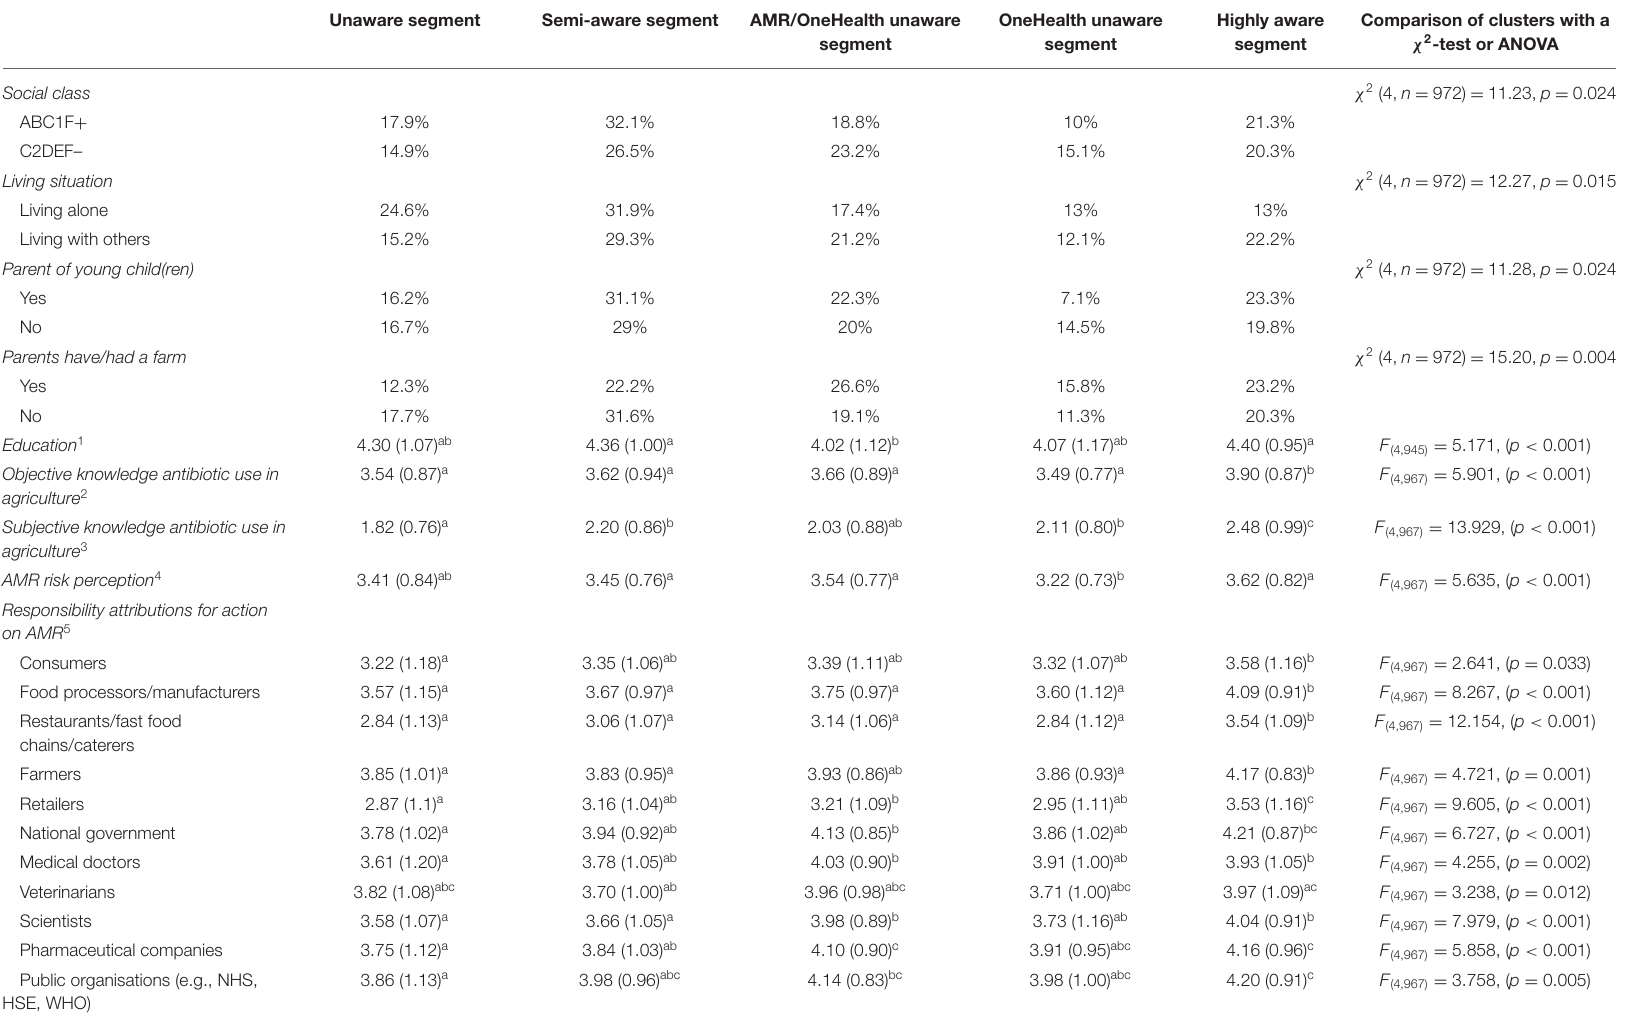
TABLE 2 | Percentages or means (and standard deviations) of socio-demographic, knowledge, and belief variables across the five